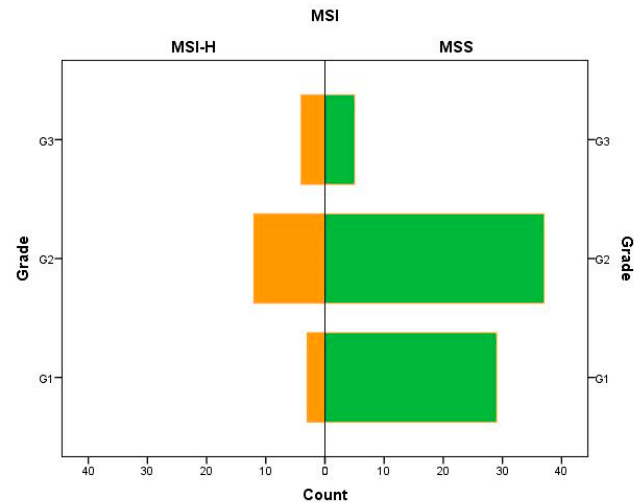
Figure 1. Patients’ distribution for histologic grade by MSI.